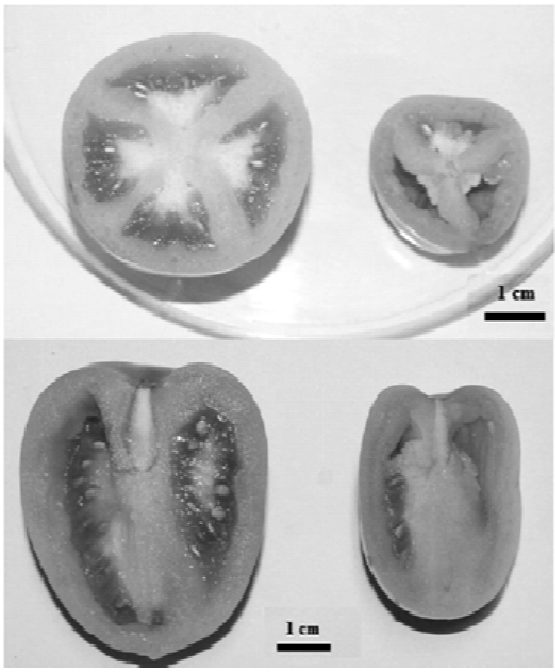
F IGURE 2. Tomatoes in cross (above) and longitudinal sections (below). The tomatoes on the left are from not bagged flowers and those on the right are from bagged flowers.